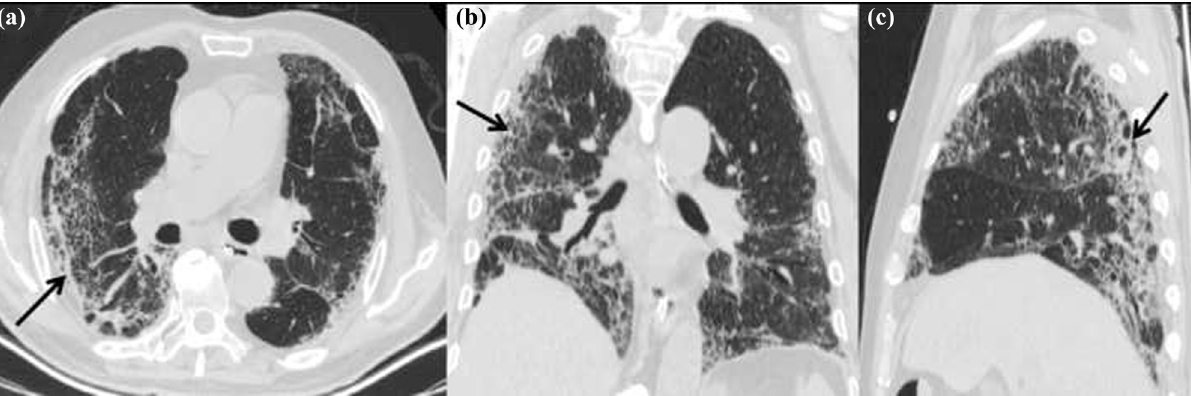
Figure 3: CT scans obtained 20 days after admission ( a: axial non - contrast CT image; b: coronal thin - section non - contrast CT image; and c: sagittal thin - section noncontrast CT image ) showing the range of lesions reduced signi fi cantly compared with previous images; fi brous changes in subpleural ( black arrows )